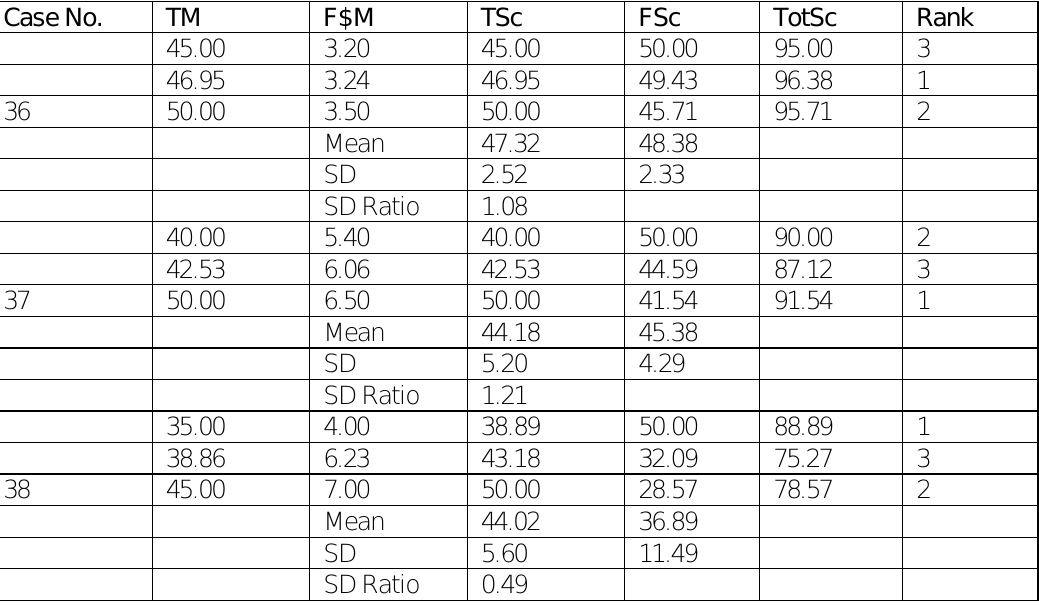
Table 2: Technical Scores, Fee Scores and Total Scores for Competition Nos. 36, 37 and 38 using Equation 2 with a 50/50 predetermined weighting Case